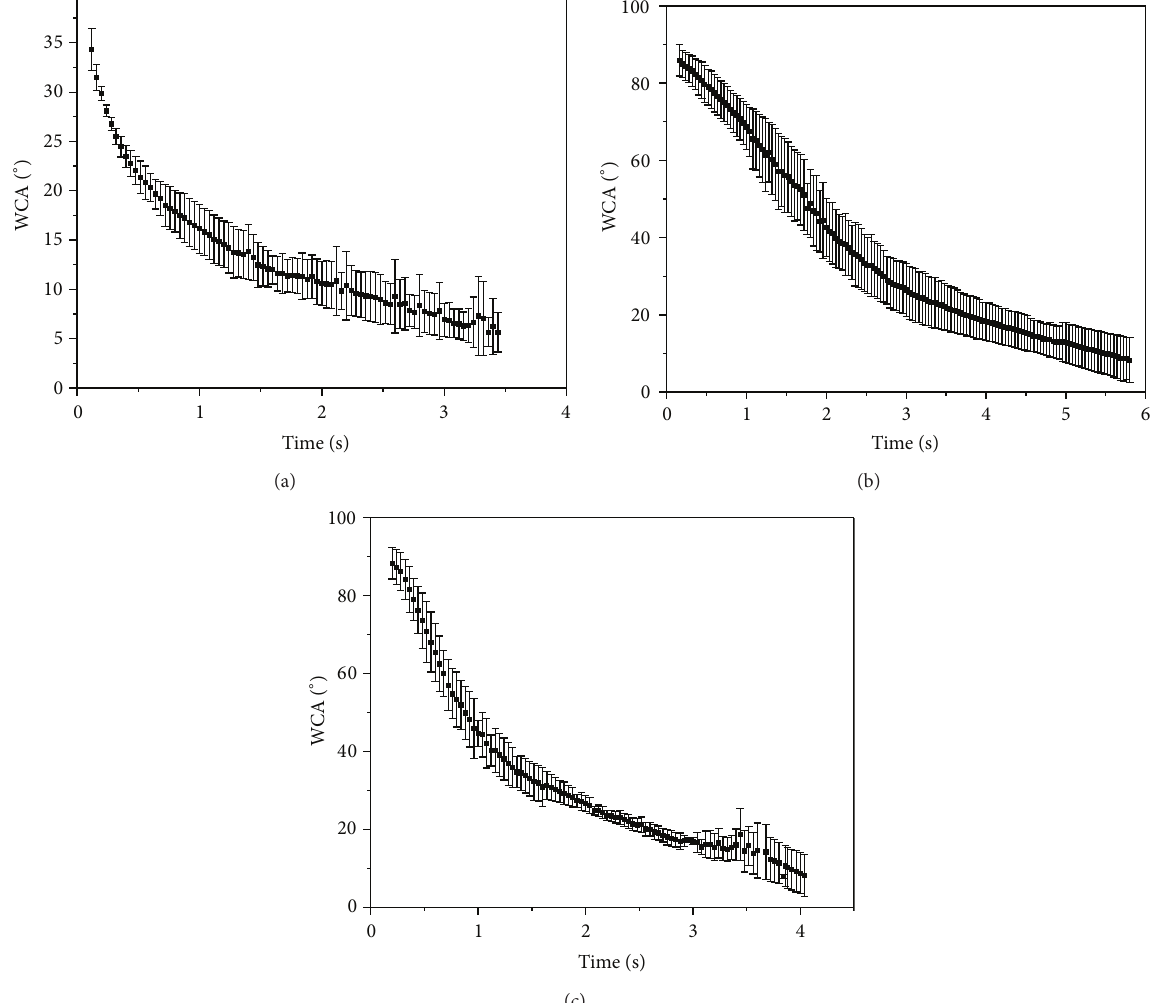
Figure 7: Evolution of the water contact angles for (a) thin coating (sample A) and thick coatings: (b) sample B, (c) sample C.